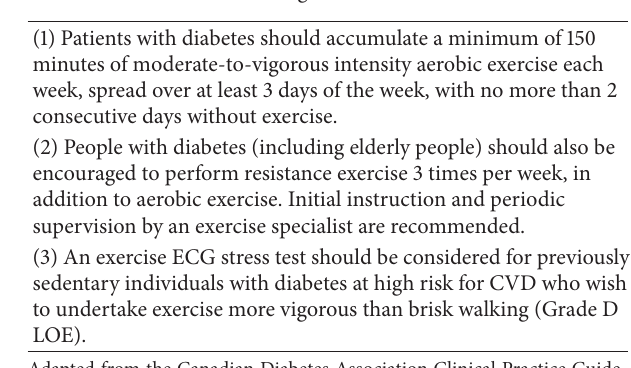
Table 3: Canadian Diabetes Association Physical Activity Recom- mendations for diabetes